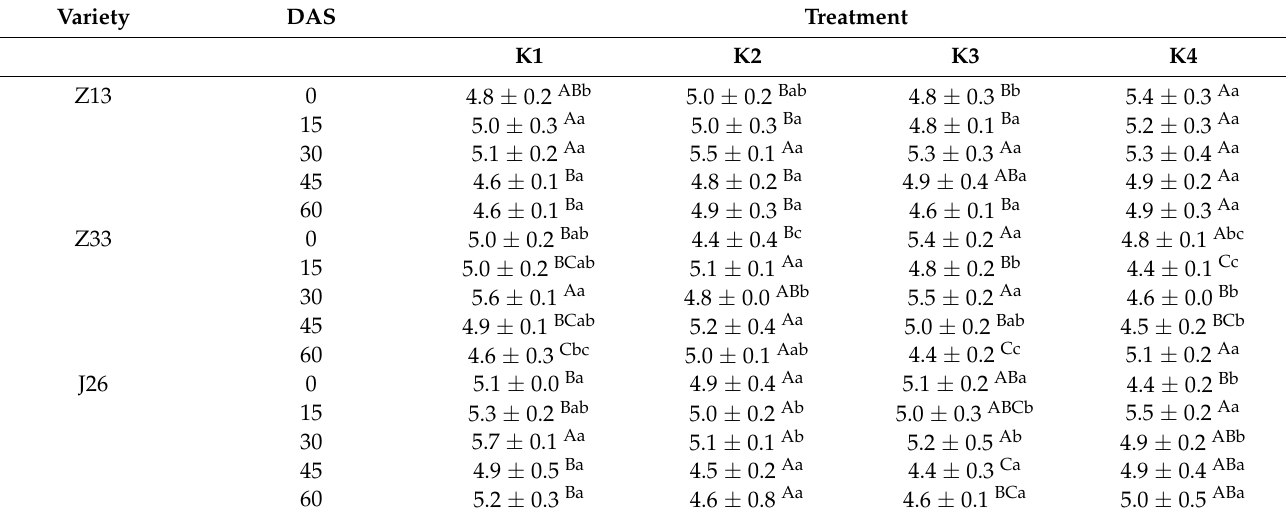
Table 3. Springiness of the slice of tuberous root (N).